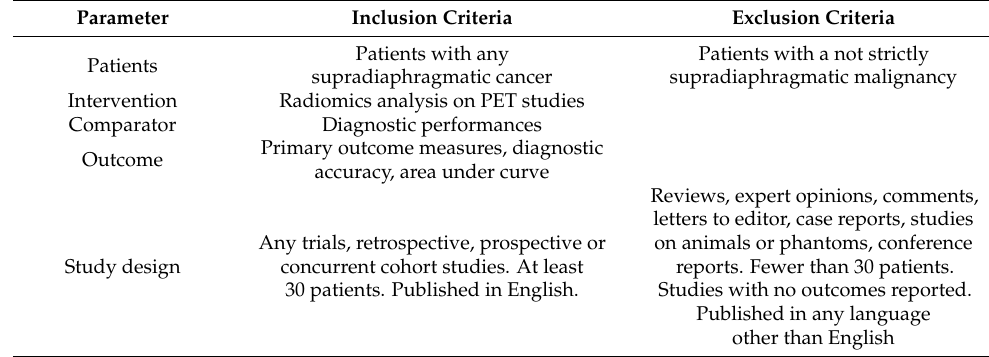
Table 1. Inclusion and exclusion criteria (PICOS